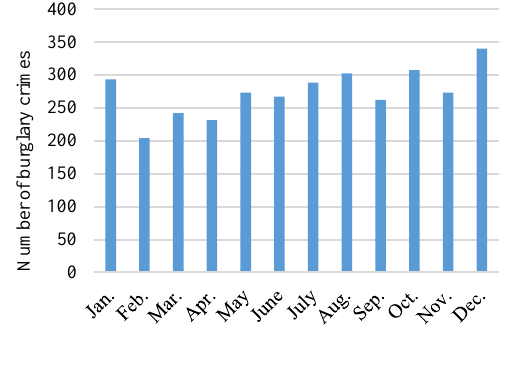
Figure 3. Overall burglary crimes by month